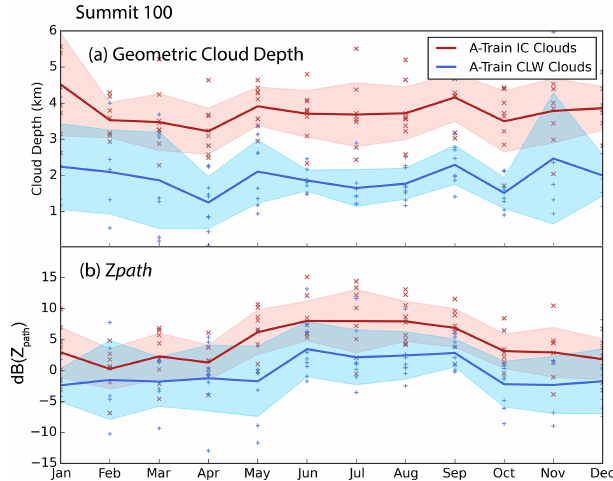
Figure 10. As in Fig. 8 except only including observations within a 100km radius of Summit